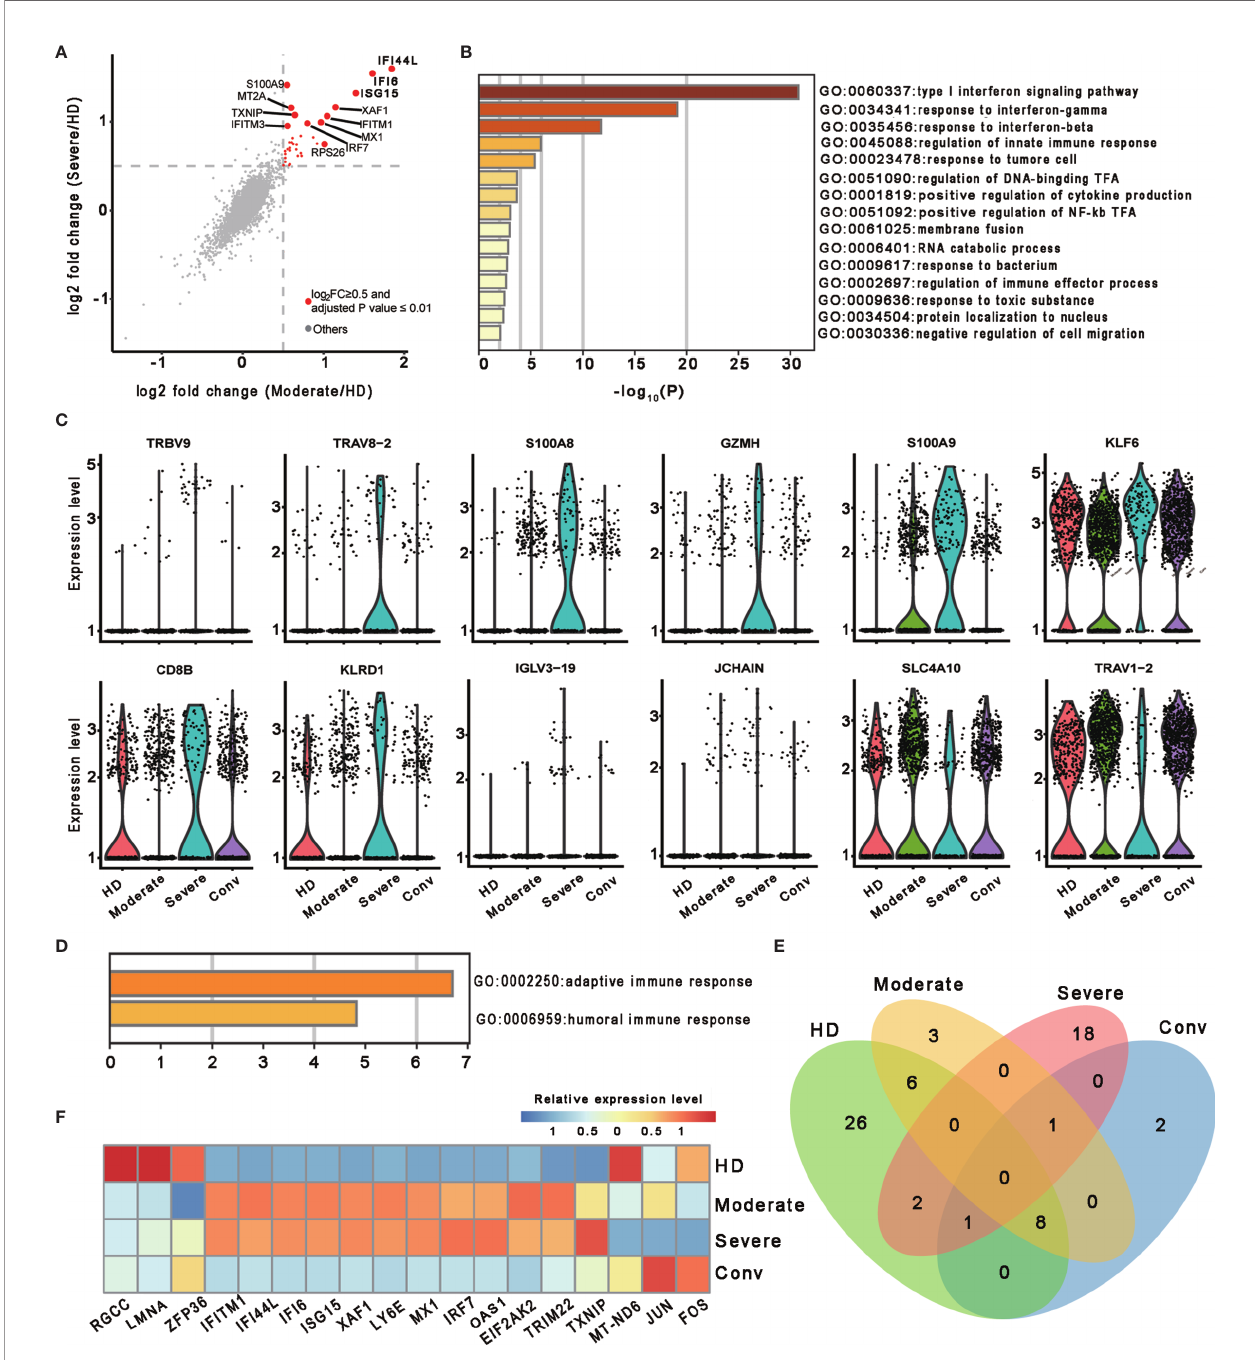
FIGURE 2 | Characterization of MAIT cells in individuals across four conditions. (A) Scatter plot showing the comparisons of DEGs in the MAIT cells between severe (or moderate) and HD controls. The red dots represent signi fi cantly upregulated genes with an adjusted P value ≤ 0.01 and average log 2 fold change ≥ 0.5. Example genes are labeled with gene symbols. The gray dots represent genes with adjusted P > 0.01 or average log2 fold change < 0.5. A two sided unpaired Mann – Whitney U-test was applied. P values were adjusted using Bonferroni correction. (B) Gene enrichment analyses of the signi fi cantly upregulated DEGs in (A) . GO terms are labeled by name and ID, and sorted by -log10(P) values. A smaller P value was expressed in a darker color. (C) Violin plots showing gene expression levels of DEGs of MAIT cells in the severe group (n = 4) in comparison with their counterparts in the moderate group (n = 7). (D) Gene enrichment analyses of the DEGs in (C) . Display settings are similar to (B) . (E) Venn diagram showing the overlapping DEGs among the HD (n = 5), moderate (n = 7), severe (n = 4) and conv (n = 6) conditions. (F) Heatmap showing the relative expression level of shared genes of (E) in at least two conditions. Rows denotes the four conditions and columns denote the shared